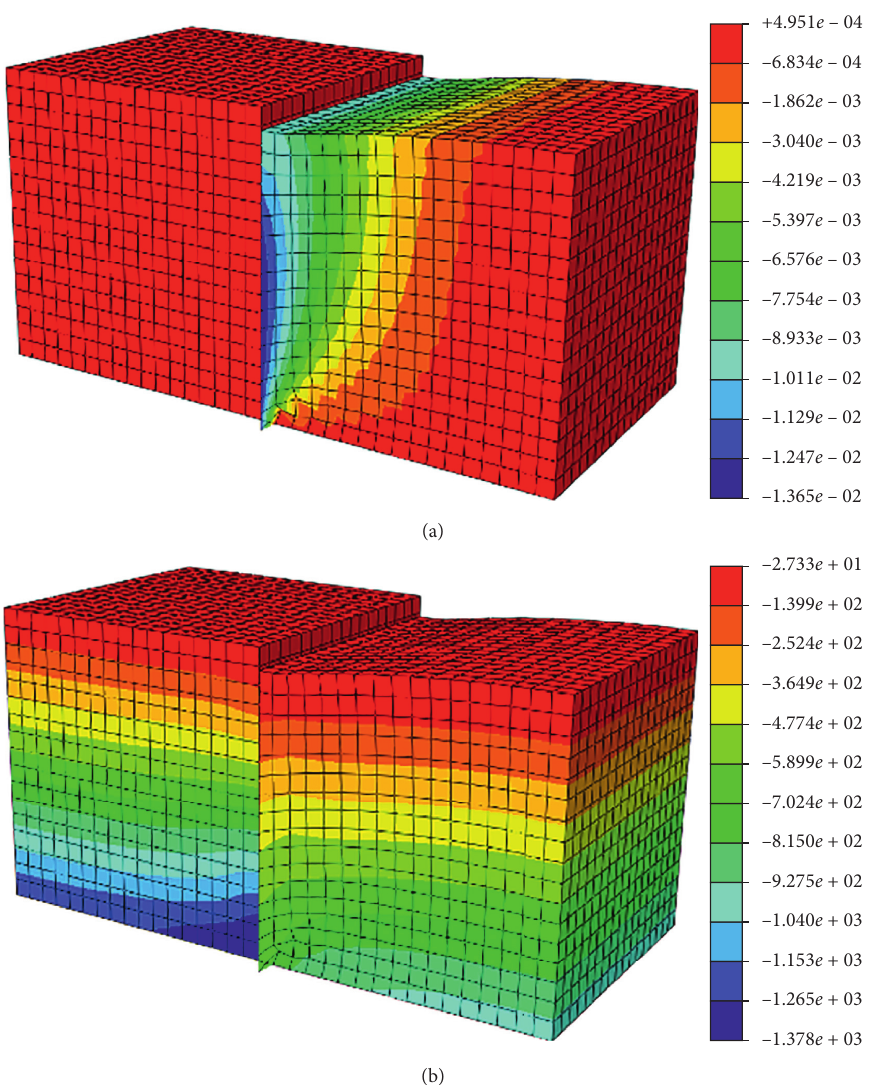
Figure 11: Simulation results of method D. (a) Displacement results (unit: m) and (b) vertical stress results (unit: kPa).